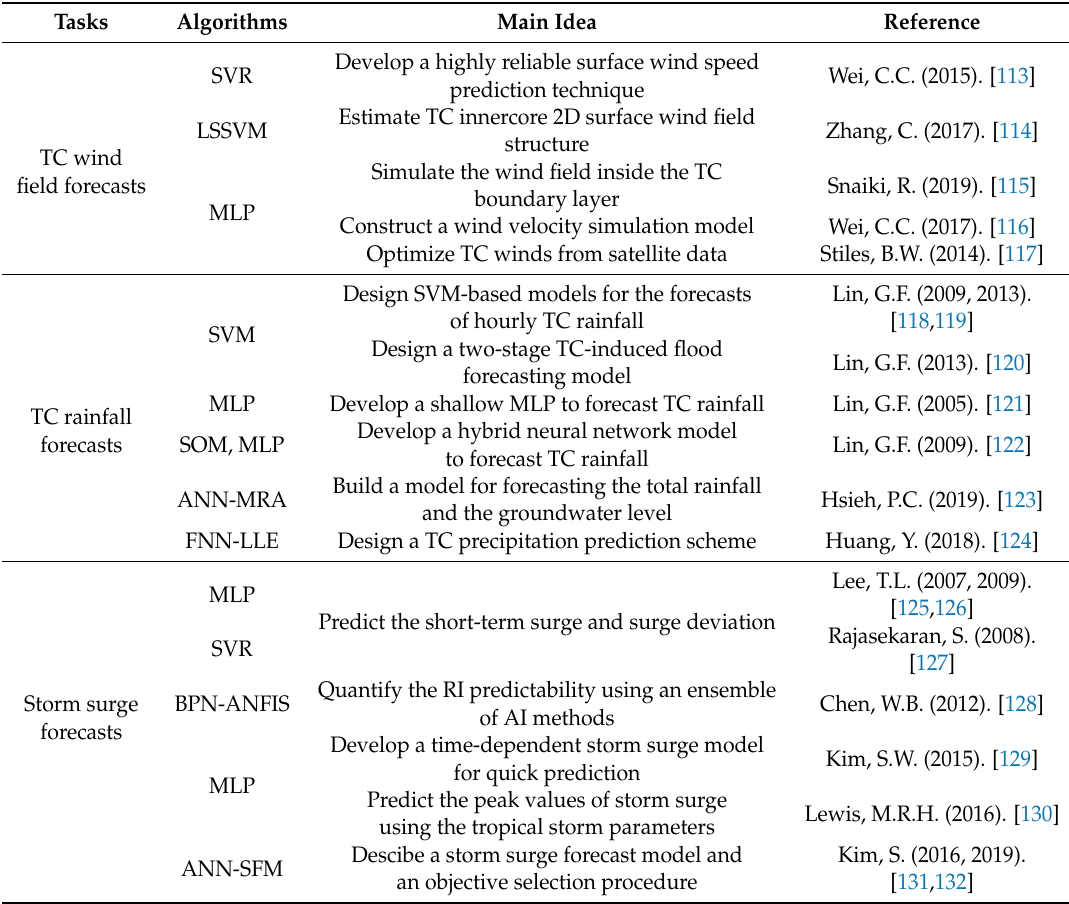
Table 4. Machine learning in TC weather and the disastrous impact